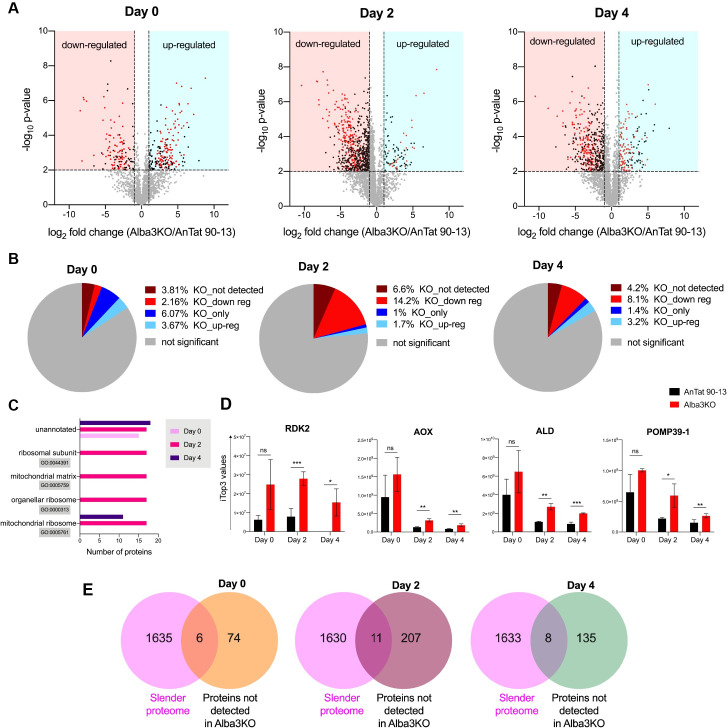
Quantitative proteome analysis of Alba3KO and AnTat 90–13 during differentiation reveals significant changes.(A) Volcano plots comparing the proteomes of AnTat 90–13 and Alba3KO on days 0 (stumpy forms), 2 and 4 of differentiation. Data were obtained from two biological replicates (with two technical replicates of each). Vertical dotted lines indicate a fold change ≥ 2 and the horizontal dotted line indicates a p value <0.01. Black dots represent differentially regulated proteins, red dots represent proteins that were detected in only one condition (i.e., detected either in AnTat 90–13 or in Alba3KO) and grey dots are proteins that do not differ significantly between AnTat 90–13 and Alba3KO. The blue region on each graph shows proteins that are up-regulated or only detected in Alba3KO. The red region shows proteins that are down-regulated or not detected in Alba3KO. (B) Pie chart indicating the percentage of differentially regulated proteins in Alba3KO on days 0, 2 and 4 of differentiation compared to AnTat 90–13. Percentages are shown for proteins that are significantly (p value <0.01, fold change ≥ 2) down/up-regulated in Alba3KO and proteins that were not detected/only detected in Alba3KO. (C) GO term analysis of significantly down-regulated proteins (p value <0.01, fold change ≥ 2) in Alba3KO compared to AnTat 90–13 on days 0, 2 and 4 of differentiation. (D) Expression levels of bloodstream form-specific proteins RDK2, POMP39-1, aldolase (ALD) and alternative oxidase (AOX) in AnTat 90–13 and Alba3KO on days 0, 2 and 4 of differentiation. Two -tailed Student’s T tests were performed. Means and SD are shown. ns: not statistically signifcant; *, p = <0.05; **, p = <0.01; ***, p = <0.001. (E) Venn diagrams comparing previously published slender proteome [24] proteins not detected in the proteome of Alba3KO on days 0, 2 and 4.